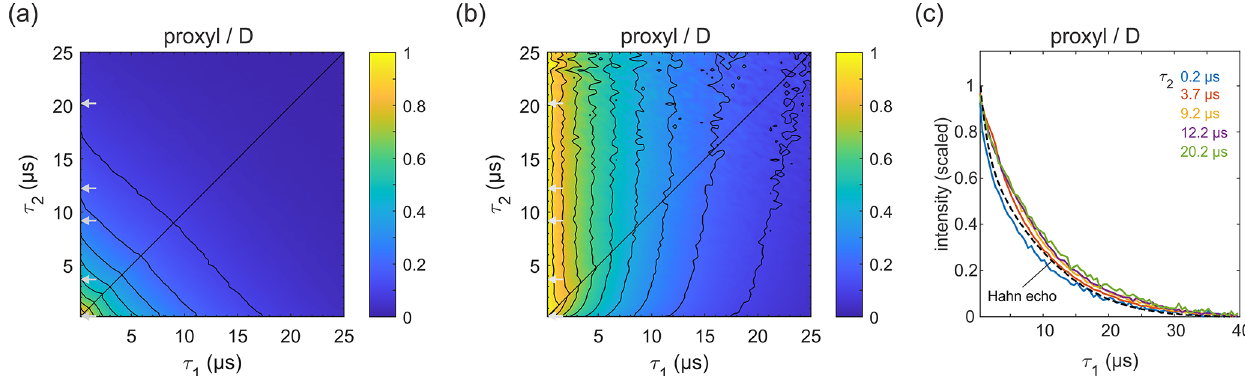
Figure 4. Refocused echo decay for 100µM 3-maleimido-proxyl in D 2 O / glycerol-d 8 (80 : 20 v/v ) at 25K. Panel (a) shows the echo amplitude as a function of τ 1 and τ 2 , and panel (b) shows the same data after normalization of each slice along τ 1 . Panel (c) shows slices along τ 1 for several τ 2 values (indicated by grey arrows in a, b ), together with a Hahn echo